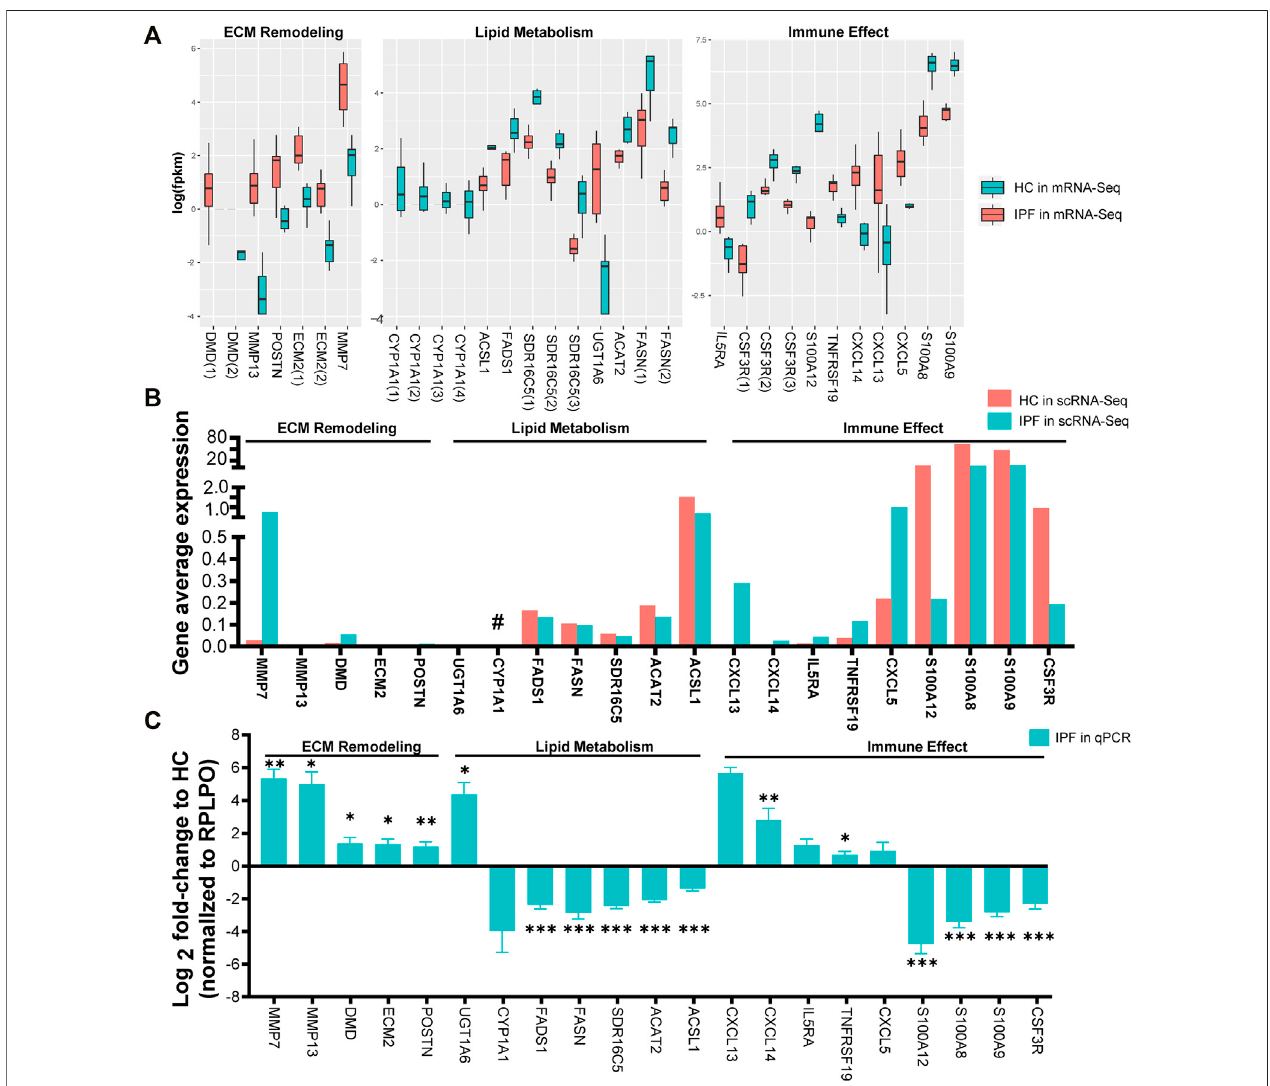
FIGURE 4 | Selection and veri fi cation of 21 target genes related to ECM remodeling, lipid metabolism, and immune effect. (A) The fpkm expression of 21 target genes related to ECM remodeling, lipid metabolism, and immune effect via mRNA-Seq analysis from lung tissues of IPF and HC. fpkm, fragments per kilobase million; Gene(NO.) represents having one or more differential transcripts of the gene in IPF compared with HC. (B) The fpkm expression of the 21 target genes via scRNA-Seq data from lung tissue of 9 (6 from SLB, 3 from lung transplantation) IPF and 4 HC. Compared with HC, the trend of IPF gene fpkm expression detected by scRNA- Seq was opposite to that of mRNA-Seq (#). (C) Relative expression ofthe 21 target genes in lung tissue of 11 (5 from SLB, 6 from lung transplantation) IPF and 7 HC via RT-qPCRexperience.RPLPOwastheinternalreference.Thebargraphsshowmean ± SEM.Statisticalsigni fi cancewassetat p < 0.05,and* p < 0.05,** p < 0.01,and *** p < 0.001 compared with HC group using a two-tailed Student ’ s